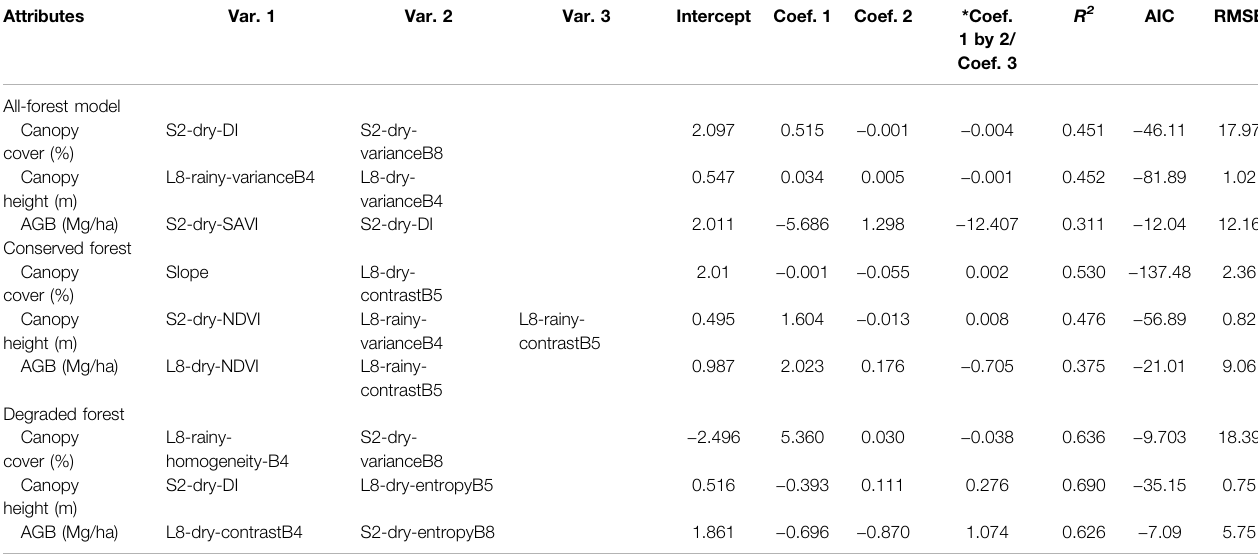
TABLE 2 | Best models for all-forest, conserved forest, and degraded forest.